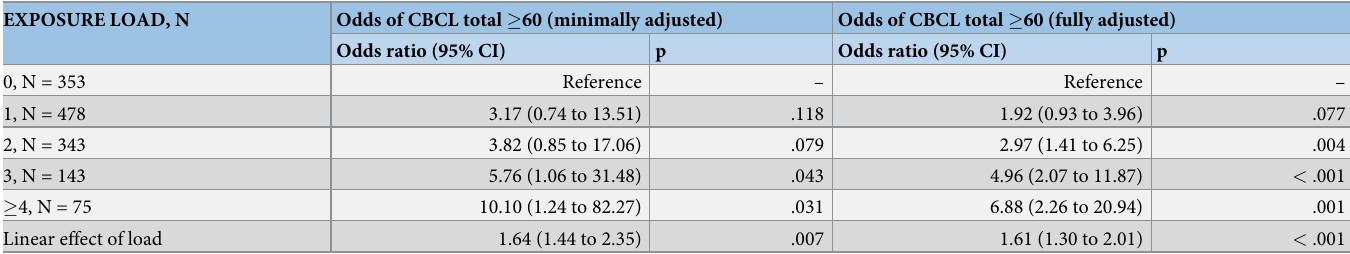
Table 3. Effect of adverse prenatal exposure load on odds of CBCL total score � 60 in the validation (sibling) sample. EXPOSURE LOAD,